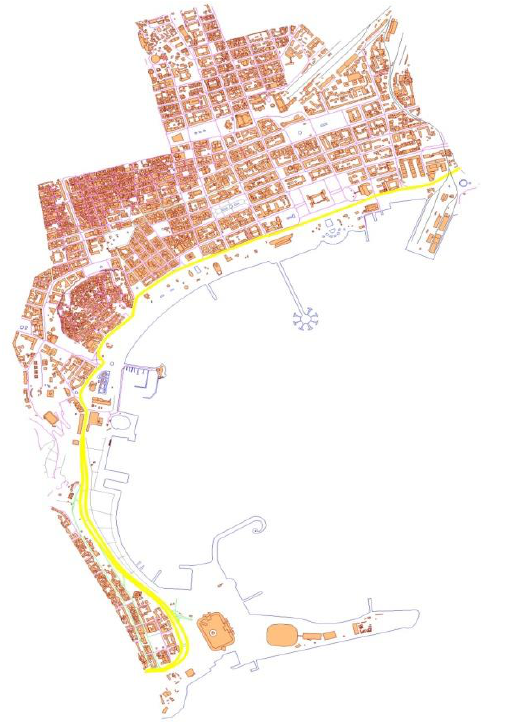
Figure 3. The selection of clutter classes.